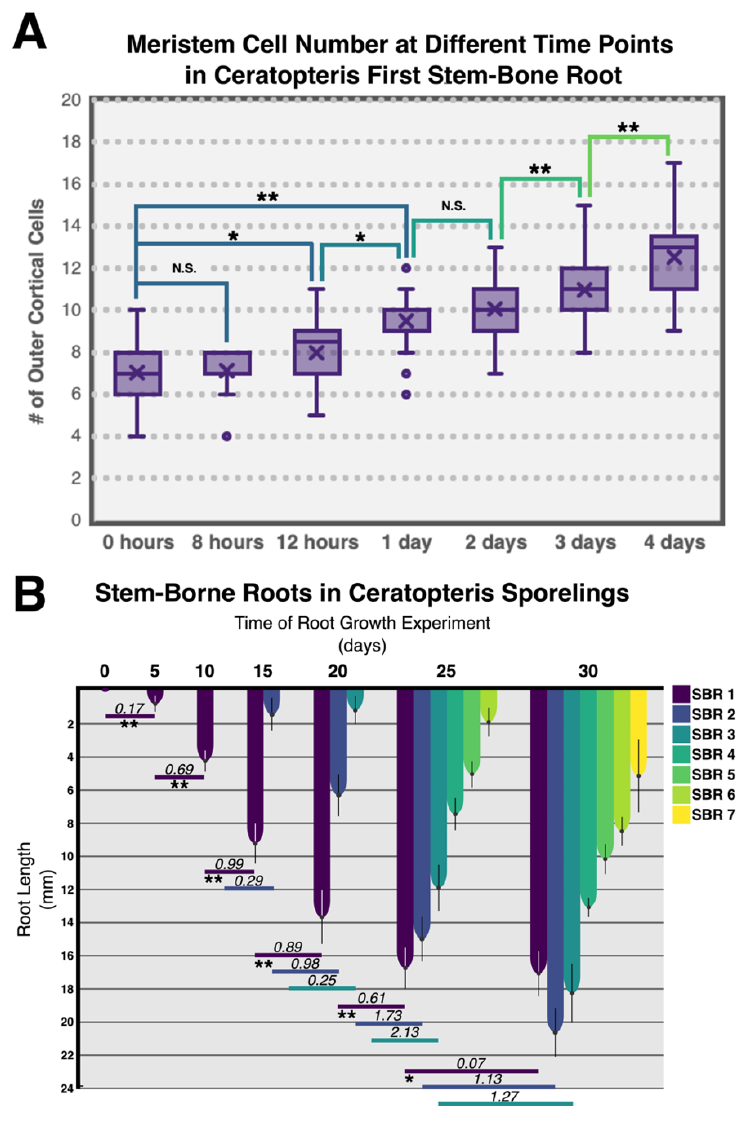
Figure 5. Root dynamics at the cell and organ level in Ceratopteris richardii. ( A ) Box plot of the analysis of the cell number in the first stem-borne root. A paired student’s t test was applied for number of cells in the meristem changing through time. ( B ) Growth analysis of the stem-borne roots. Column plot showing the growth analysis of stem-borne roots in Ceratopteris sporelings. Horizontal lines describe the growth rate of each SBR (according to color) in a timespan of 5 days. The statistical differences of root growth were assessed with a paired student’s t test. Standard deviation is displayed in each column. * p < 0.05; ** p < 0.01; NS—non significant.